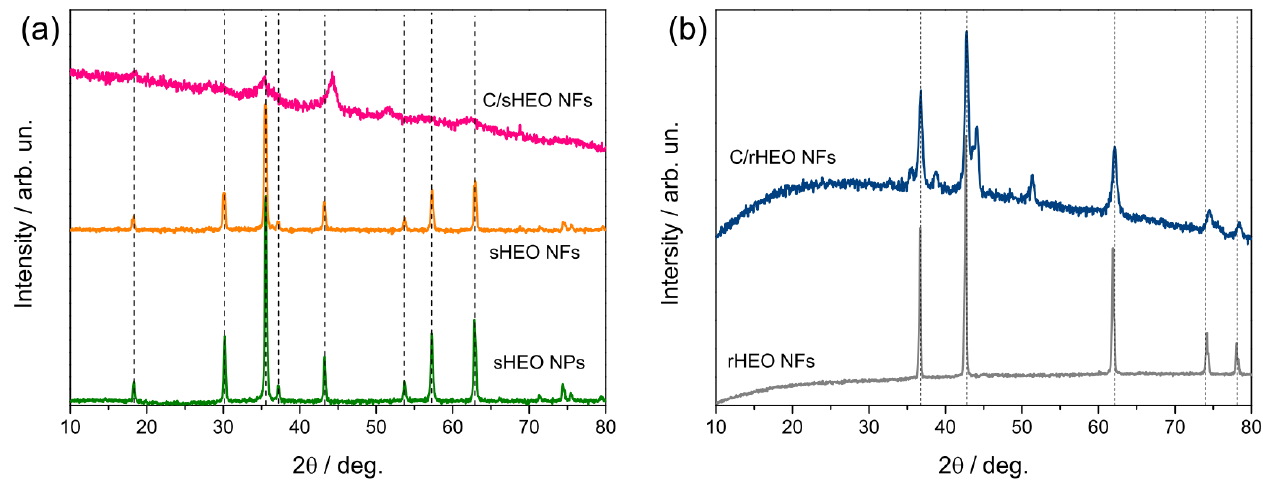
Figure 2. XRD patterns of ( a ) sHEO NPs, sHEO NFs, and C/sHEO composite NFs and ( b ) C/rHEO composite NFs (the pattern of rHEO NFs is also reported for comparison